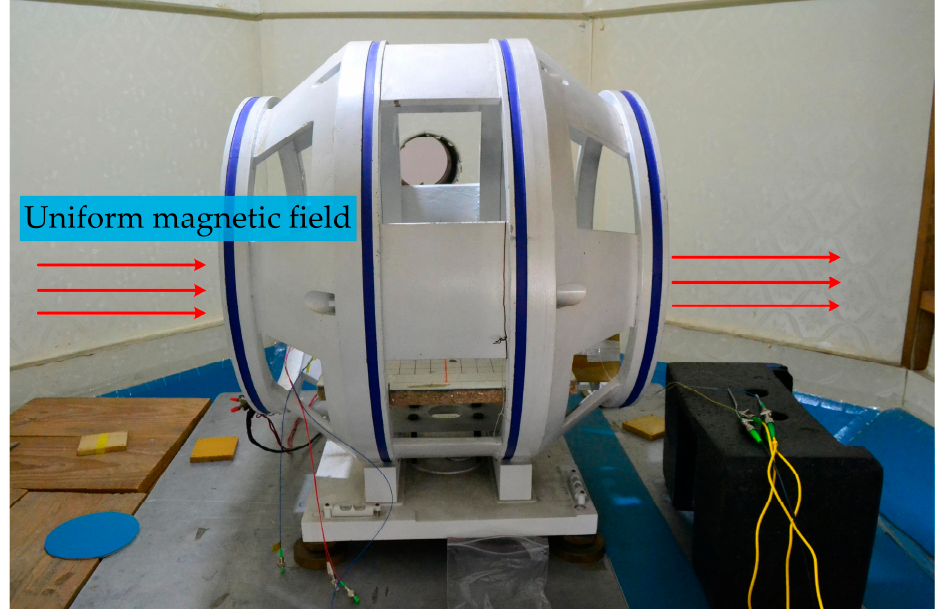
Figure 5. The uniform magnetic field is generated by applying current to the coil in zero magnetic space.